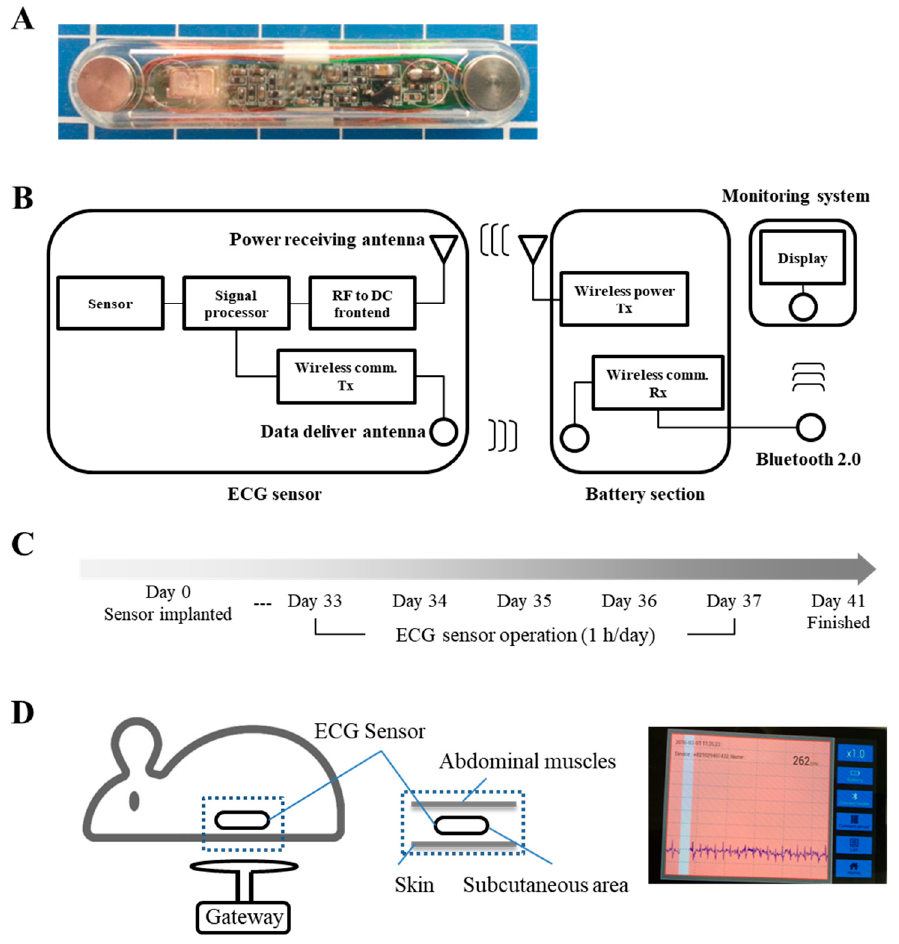
Figure 1. ( A ) An ECG sensor with the electrode of the anode; ( B ) Schematic view of the system. Dual antenna structure of a wirelessly powered sensor; ( C ) Schematic representation of the model for experimental conditions; ( D ) An ECG sensor was implanted subcutaneously within the rat, and the ECG signal was checked using a wireless charging and Bluetooth system.